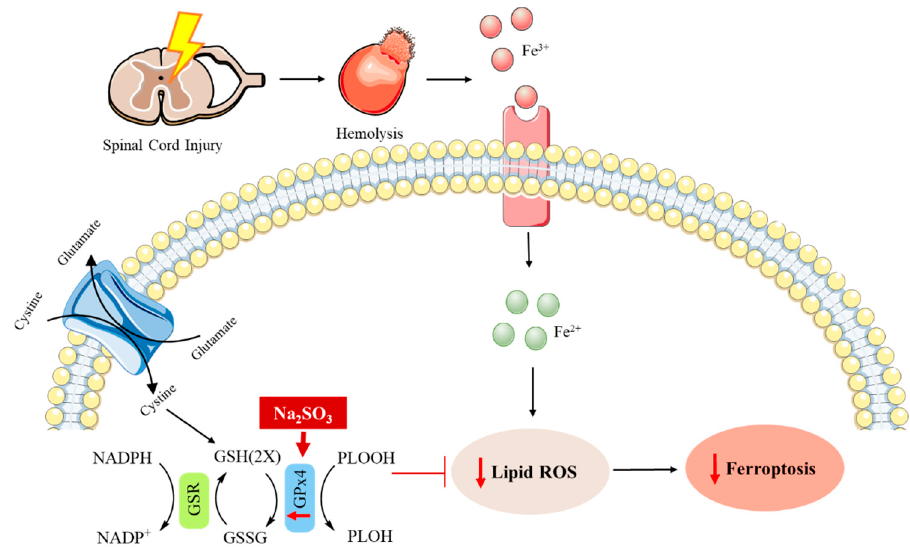
Figure 3. The possible underlying mechanism by which Na 2 SO 3 boosts the recovery of the neuro- logical function of rats with spinal cord injury through GPx4